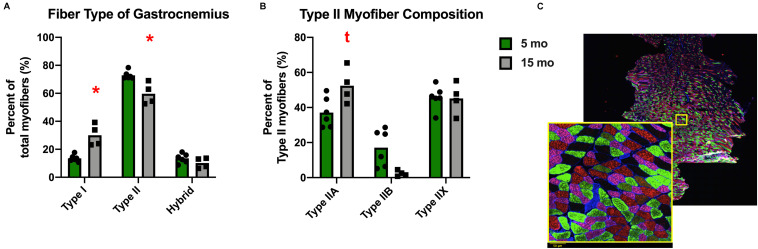
Fiber type composition of the gastrocnemius of Dunkin Hartley guinea pigs. There was a significant greater amount of type I myofibers and lesser amount of type II myofibers in 15 mo Dunkin Hartley guinea pigs compared to 5 mo guinea pigs (A). There is a trend (p = 0.07) for less type IIB myofibers in 15 mo guinea pigs as well (B). The example of fiber typing includes a zoomed in portion to show detail. Laminin was fluorescent at 350 nm, type I fibers were fluorescent at 647 nm, type IIA fibers at 488 nm, and type IIB fibers at 555 nm. Fibers that were negative under all channels were classified as type IIX. Scale bar (bottom left) = 50 μm. (C). *denotes p < 0.05 compared to 5 mo; t denotes p < 0.10 compared to 5 mo.